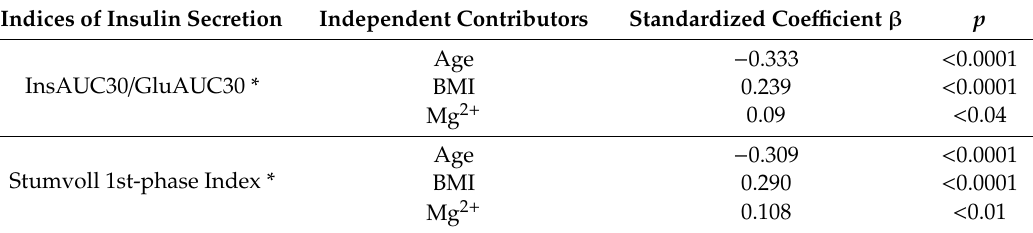
Table 3. Multiple regression analysis with indices of insulin secretion as dependent